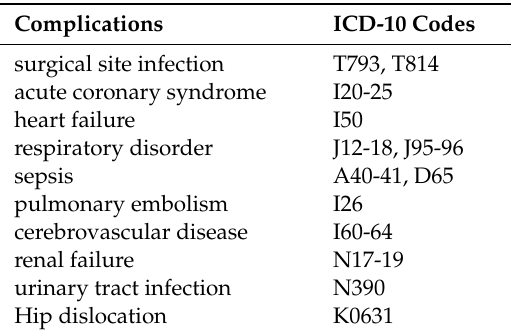
Table A2. ICD-10 definitions for